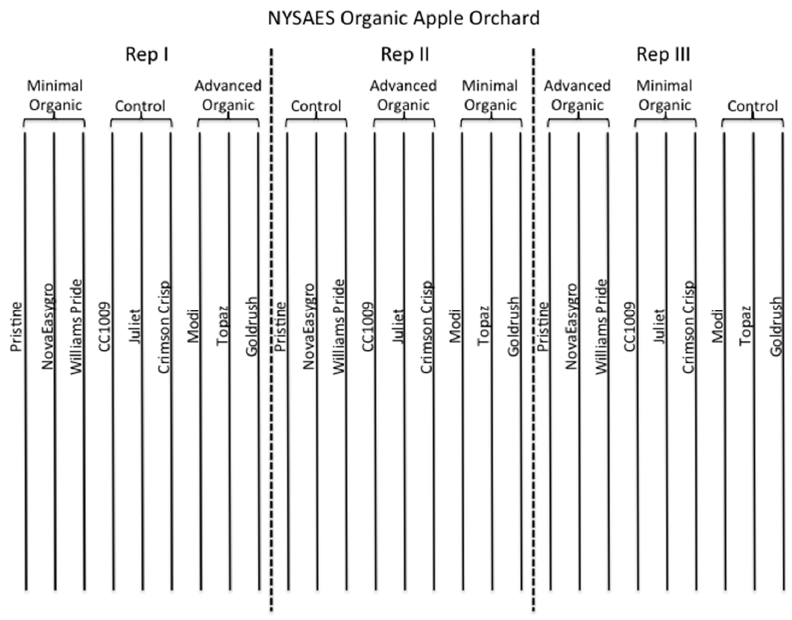
Figure 1. Layout of organic apple orchard showing varieties, treatments, and replicated plots, New York State Agricultural Experiment Station, Geneva.